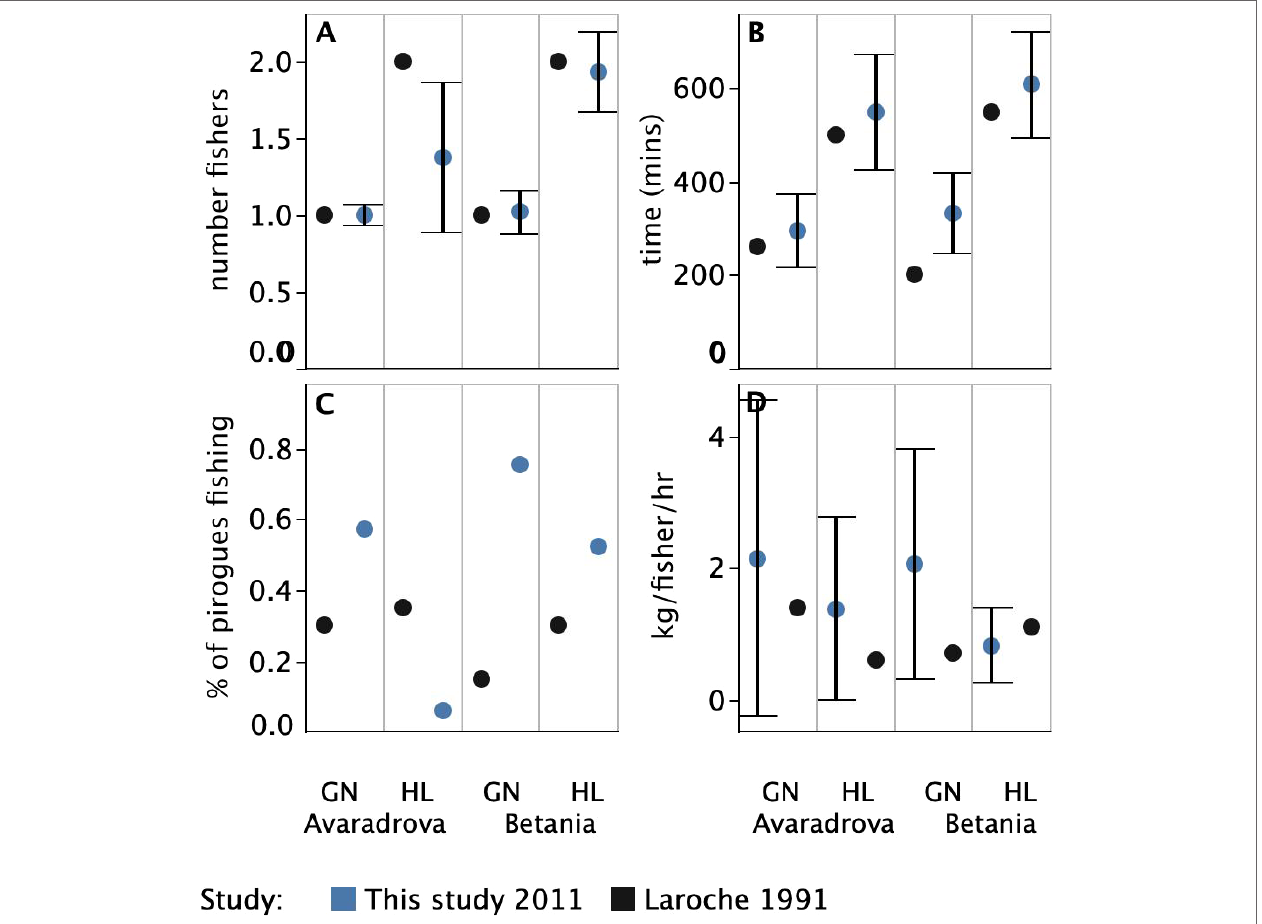
FIGURE 5 | Comparisons between the 4 main fishing effort variables used by Laroche et al. (1997). (A) Average number fishing by gear type (FISHM). (B) Average duration (minutes) of a trip (LENG). (C) Average daily activity (ACTI - the estimate of the daily proportion of pirogues fishing), and (D) Average catch per unit effort (kg person -1 h -1 ) (CPUE). Error bars indicate standard deviation. Variation was not reported by Laroche et al. (1997) and thus error bars are not shown for 1991